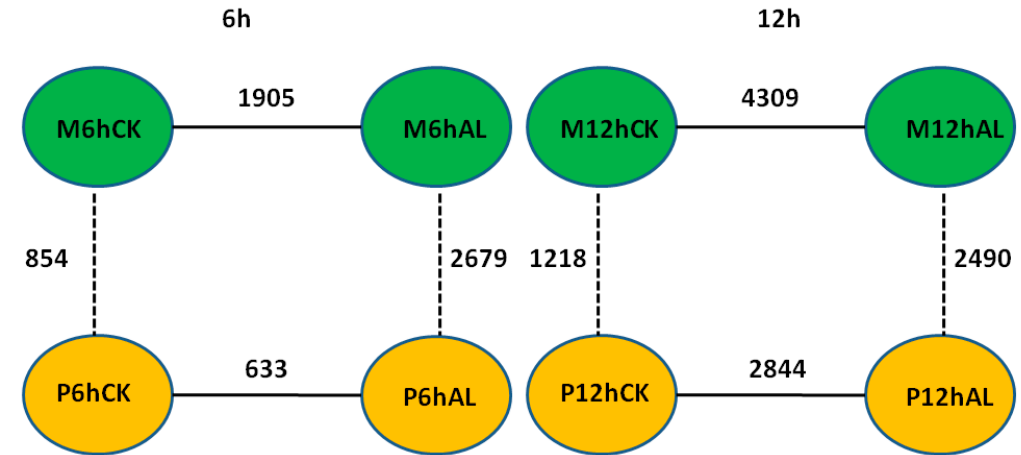
Figure 2. Diagram of the differentially expressed genes (DEGs) identified from different comparisons between samples from the two soybean varieties under Al stress (25 μ M AlCl 3 , pH = 4.3) and control (0 μ M AlCl 3 , pH = 4.3) at 6 and 12 h.